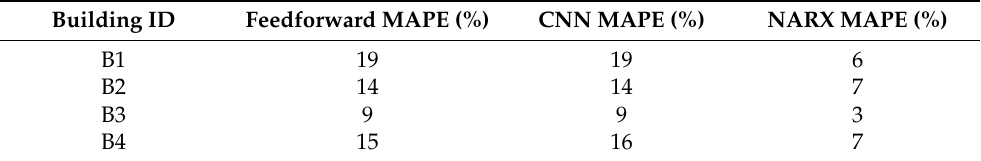
Table 3. Feedforward, CNN and NARX networks mean absolute percentage error for all buildings. Building ID